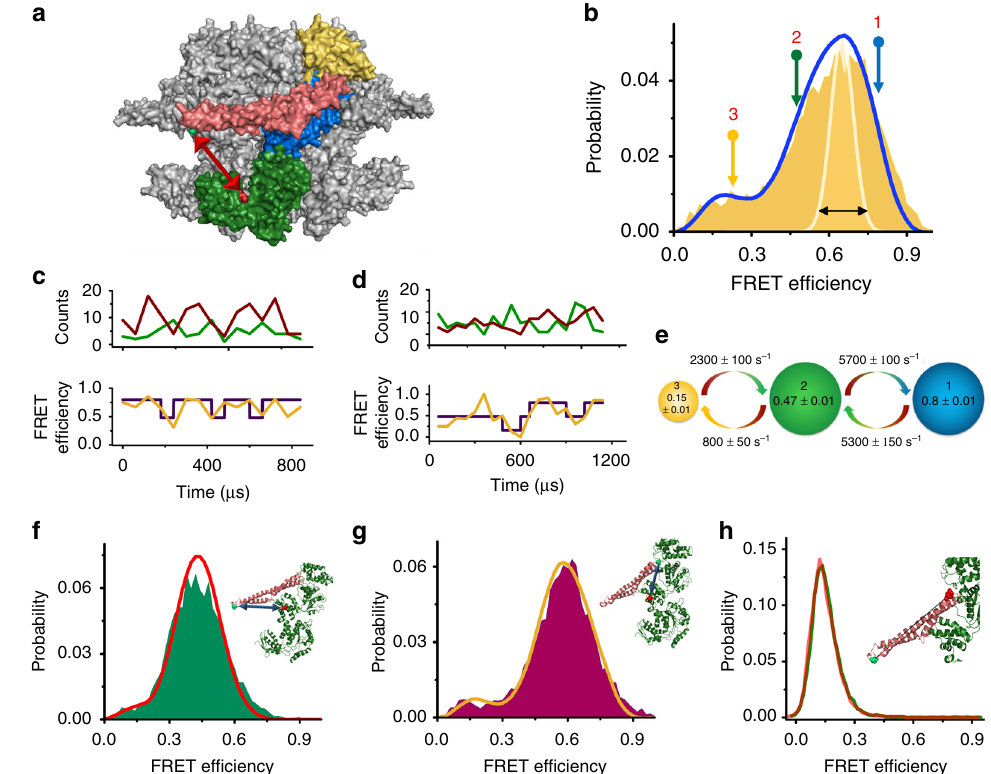
Fig. 1 M-domain conformational dynamics measured with smFRET. a Hexameric model of ClpB reconstructed from the Thermus thermophilus monomer structure (PDB: 1QVR) 26,53 . One monomer is highlighted, with the N-terminal domain in gold, the two nucleotide binding domains, NBD1 and NBD2, in blue and green, respectively, and the M domain in salmon color. The red arrow points to the attachment positions for donor and acceptor dyes (S428 and S771, respectively). b FRET ef fi ciency histogram of double-labeled ClpB (S428C-S771C). White line and black arrow indicate expected width based on shot noise. The blue line is the outcome of a ” recoloring ” simulation (see Methods). The arrows above the histogram show the positions of the three states obtained from H 2 MM analysis. c , d Two single-molecule trajectories binned at 60 µ s. Top panel in each section shows the donor and acceptor signals (green and red, respectively), while the bottom panel shows the FRET ef fi ciency obtained from the signals in orange, with the purple line representing state assignment obtained from H 2 MM analysis. e Results of the H 2 MM analysis of a smFRET measurement of ClpB (S428C-S771C) in the presence of ATP. See also Supplementary Fig. 8. The interconversion rates between the states are shown above and below each arrow. The occupancy of each state is represented by the size of the circle (state 1 – 43 ± 1%, state 2 – 42 ± 1%, and state 3 – 15 ± 1%). FRET ef fi ciencies are shown inside the circles. f , g FRET ef fi ciency histograms from experiments with two additional donor-acceptor pairs: 428 – 359 ( f ) and 483 – 359 ( g ). Inset in each panel shows the monomer structure with the donor and acceptor sites marked (green and red, respectively). Red and orange lines in ( f ) and ( g ), respectively, are the outcomes of “ recoloring ” simulations (see also Supplementary Fig. 9). h FRET ef fi ciency histograms of a ClpB variant with cysteines on the two ends of the M domain, S428C- N487C (see inset for structure, with cysteine positions shown in green and red). Histograms were measured in the presence of 2 mM ATP (red) and in the absence of ATP (green). The Errors represent standard errors of the mean. Source data are provided as a Source Data fi